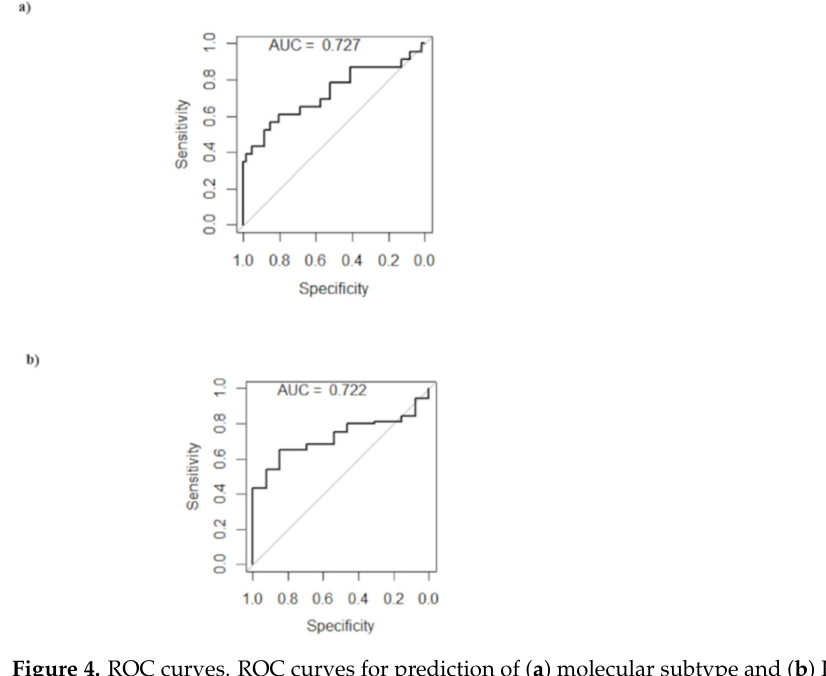
Figure 4. ROC curves. ROC curves for prediction of ( a ) molecular subtype and ( b ) Ki67 according to radiomic models.